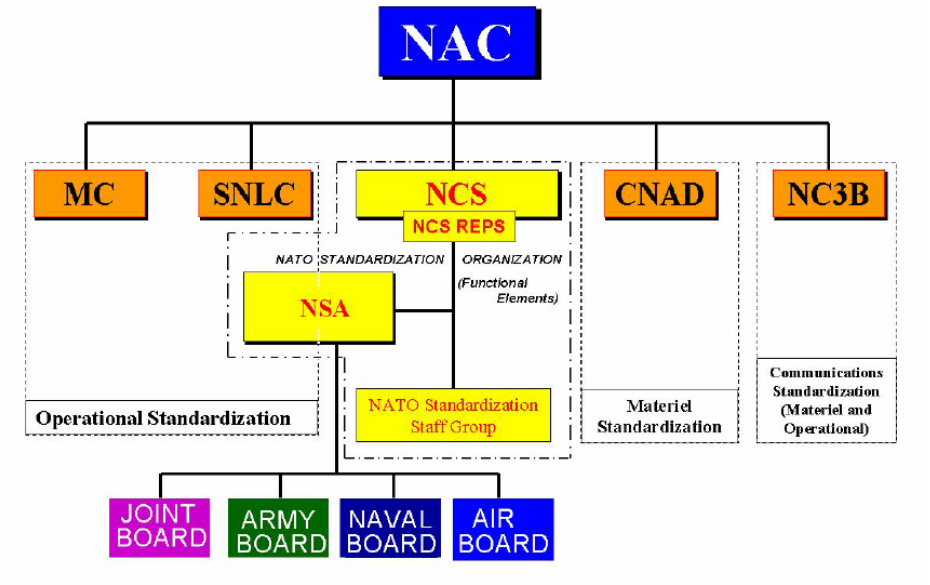
Sl. 1 – Struktura sistema za standardizaciju u NATO: NAC = North Atlantic Council; MC = Military Committee; SNLC = Senior NATO Logisticians' Conference; NCS = NATO Committee for Standardization; CNAD = Conference of National Armaments Directors; NC3B = NATO Consultation, Command and Control Board; NSA = NATO Standardization